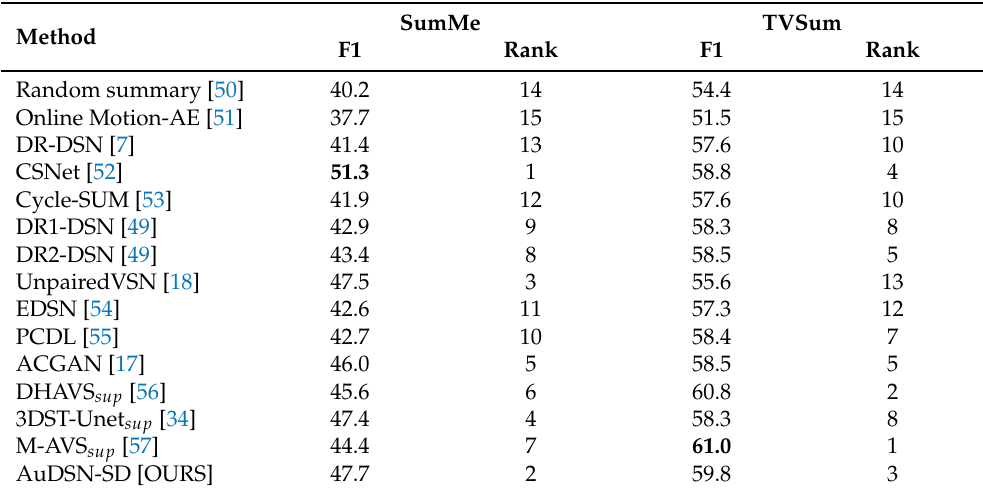
Table 4. Performance (F-scores (%)) of the proposed method compared to existing methods.